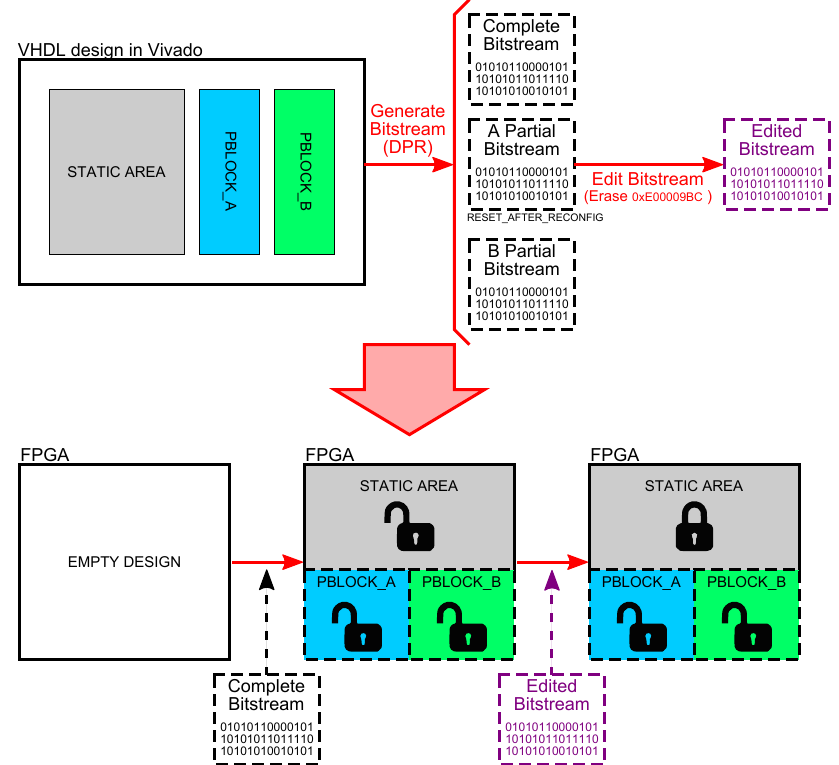
Figure 5. Approach to unprotect several regions in 7 series devices based on the RESET_AFTER_RECONFIG